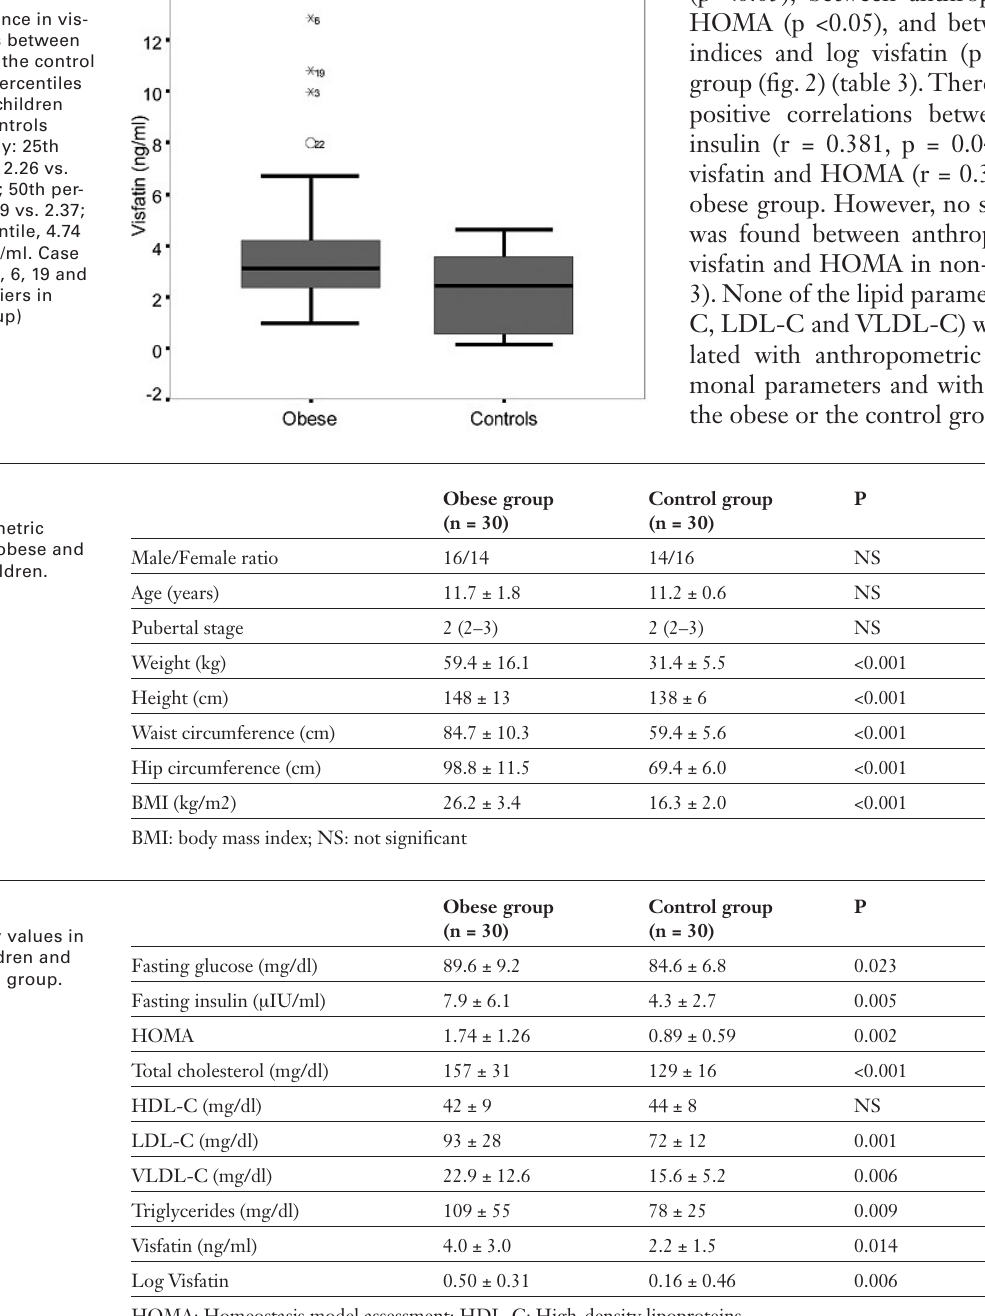
The difference in vis- fatin levels between obese and the control children (Percentiles for obese children and the controls respectively: 25th percentile, 2.26